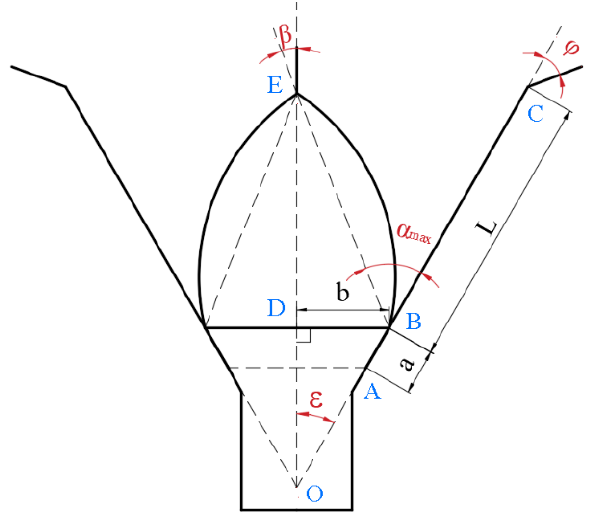
Figure 7. Schematic diagram of fingertip contact.